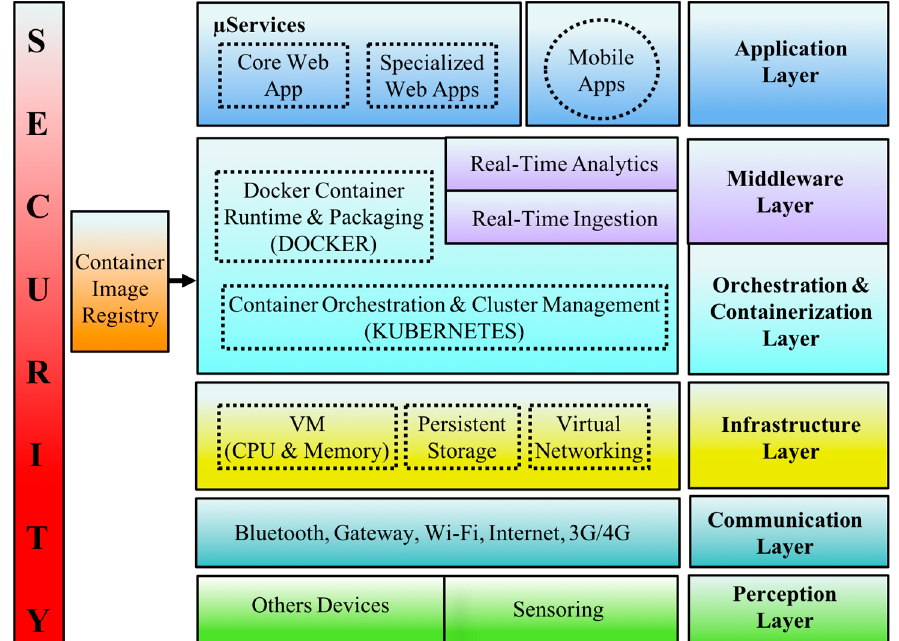
Figure 3. Layer Figure 3. Layer view. Figure 3. Layer view.